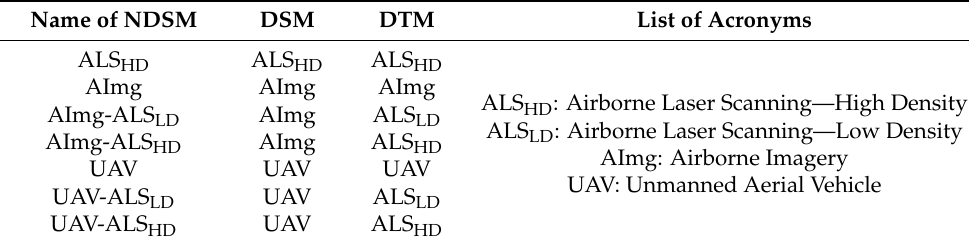
Table 3. Brief descriptions of seven calculated nDSMs and their remote sensing data inputs. Presented nDSMs were created based on the subtraction of the respective DTMs from